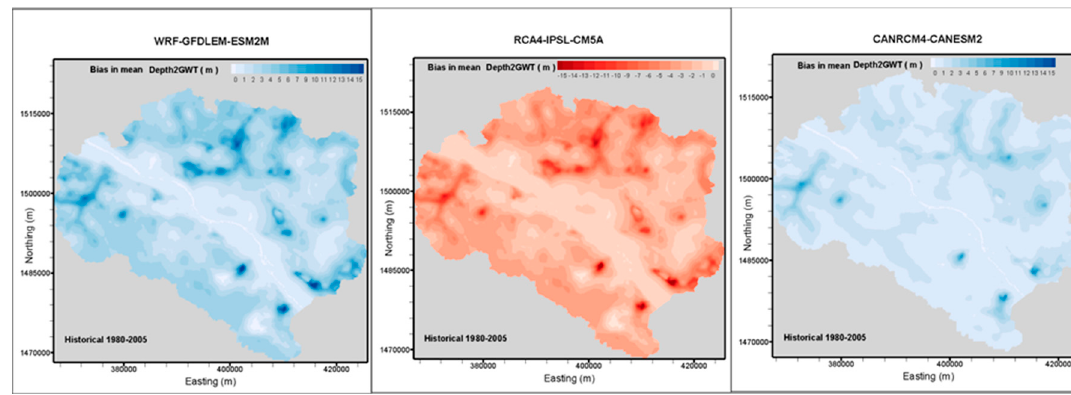
Figure 5. Simulated observed historical mean depth-to-groundwater table for 1980–2005.